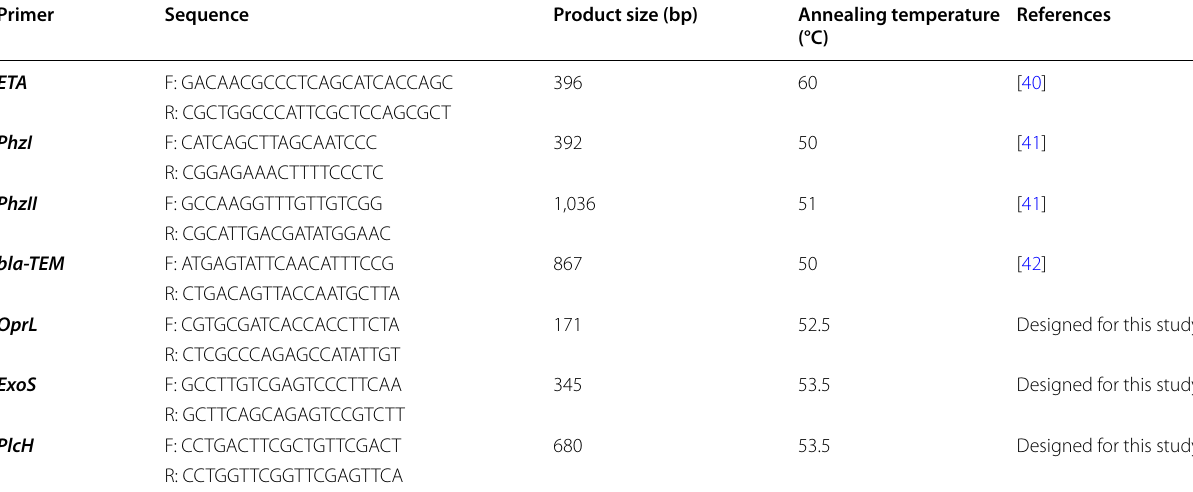
Table 1 Primer set sequences for the seven virulence and resistance genes Primer